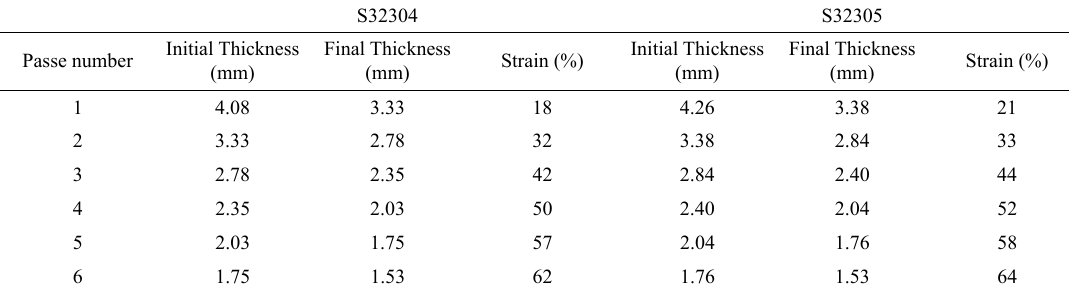
Table 2. Parameters used in cold rolling a) S32304 and b) S32205.